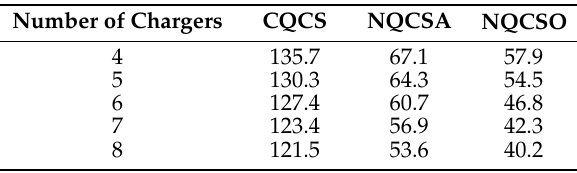
Table 4. Average stay time of charged EVs for CS with different number of chargers in different charging situations (unit: min).